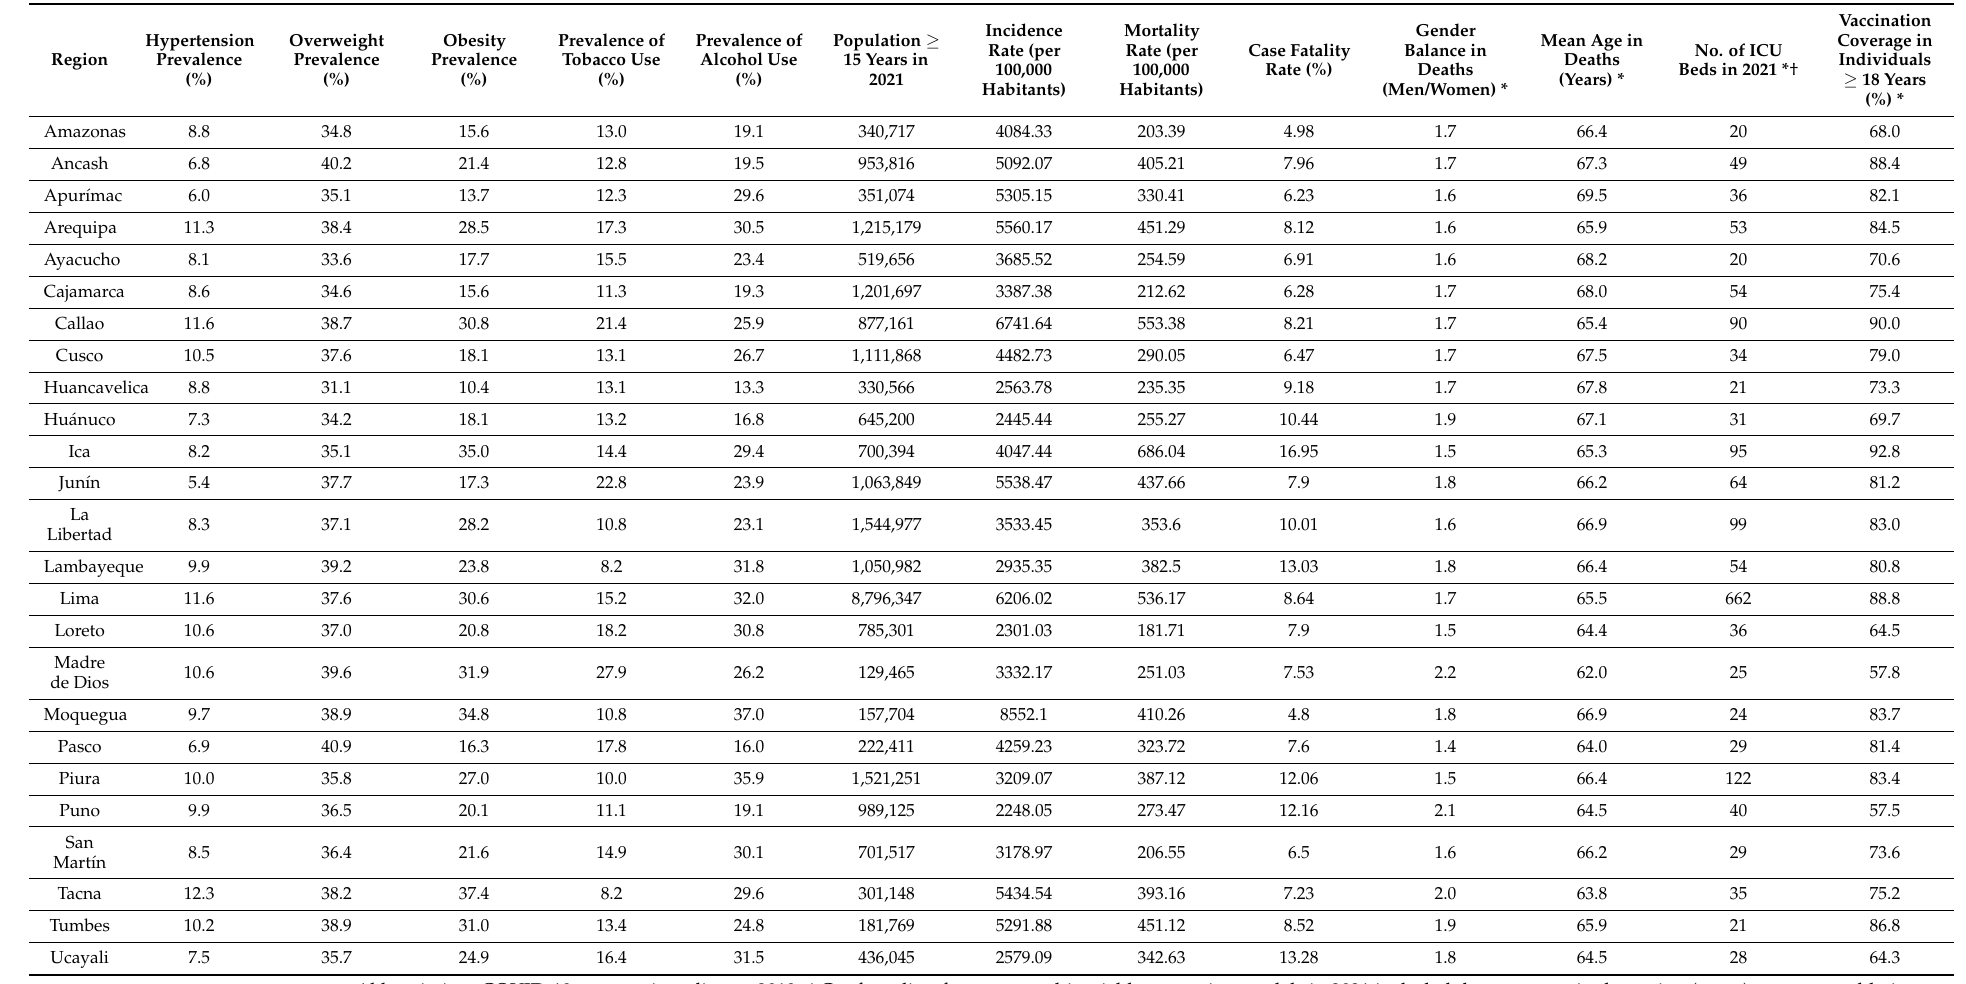
Table 2. Prevalence rates of hypertension, overweight and obesity, smoking, and alcohol use and the incidence, mortality, and fatality rates due to COVID-19 in ≥ 15 year in 25 Peruvian regions in